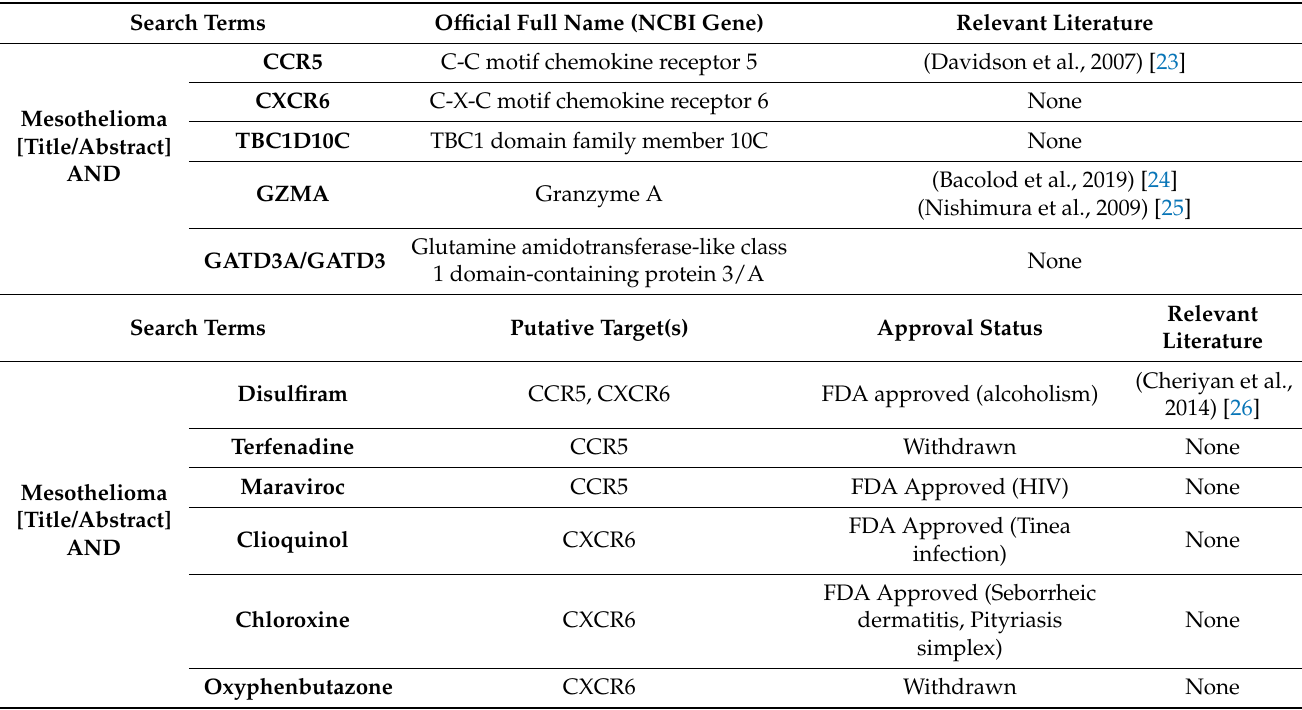
Table 1. Assessment of the literature linking mesothelioma and the genes identified in Figure 2 and literature validation of the putative repurposed drugs identified. Approval information was taken from [12] Bolded entries indicate search terms